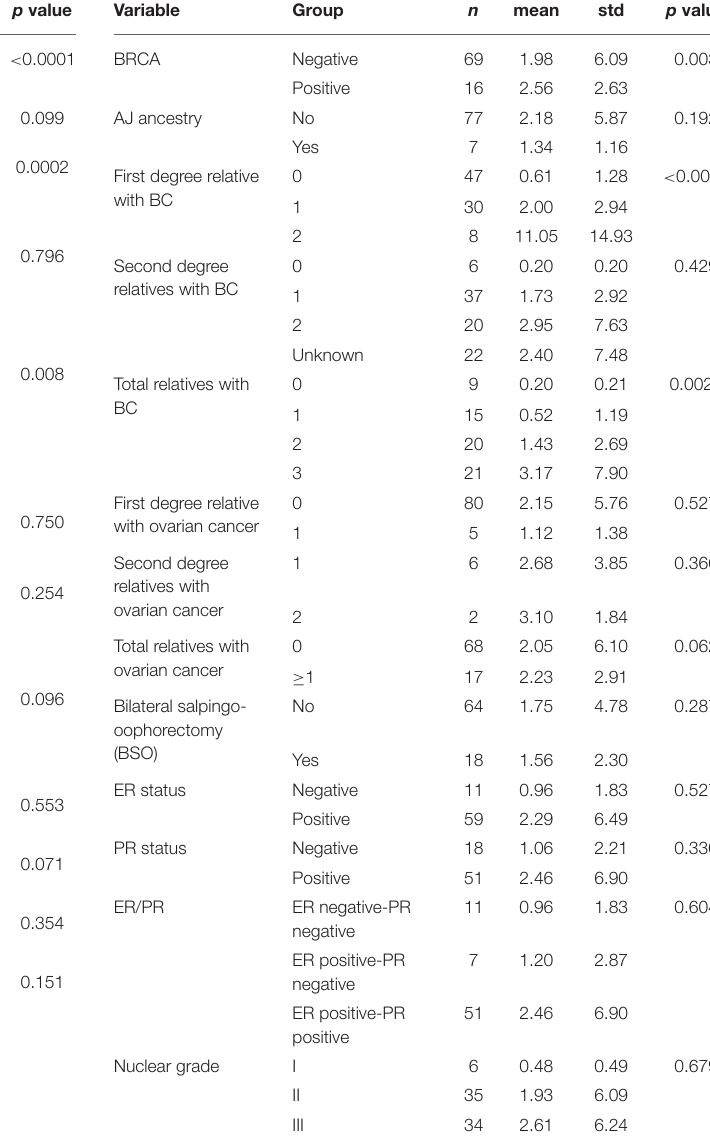
TABLE 3 | Comparisons of BRCAPRO at 10 years later than age of diagnosis by patient’s characteristics. Variable Group n